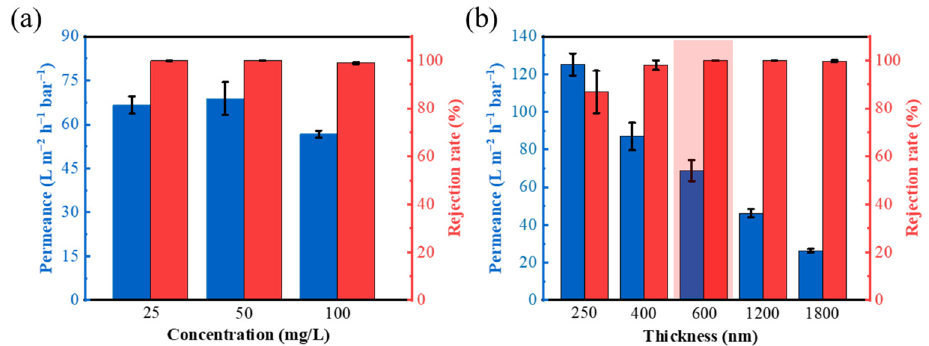
Figure 3. ( a ) Water permeance and rejection of CoCl 2 solutions through the AH-rGO membranes as a function of ion concentration. ( b ) Water permeance and rejection of 50 mg/L CoCl 2 solutions through the AH-rGO membranes as a function of thickness. The selected optimal thickness is highlighted by the region shaded red.